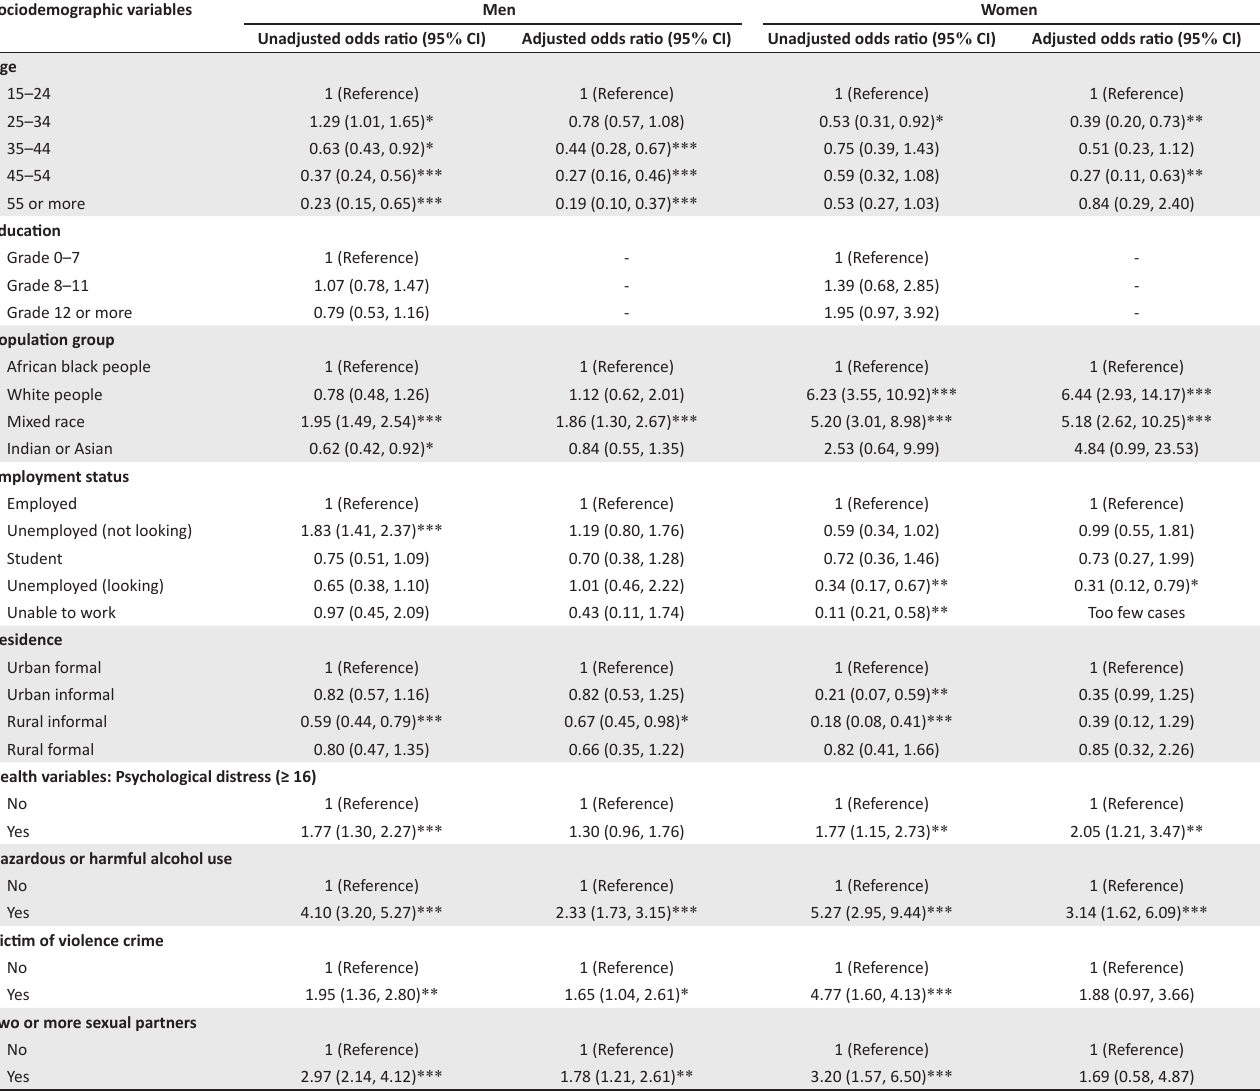
TABLE 2: Association between sociodemographics, health variables and drug